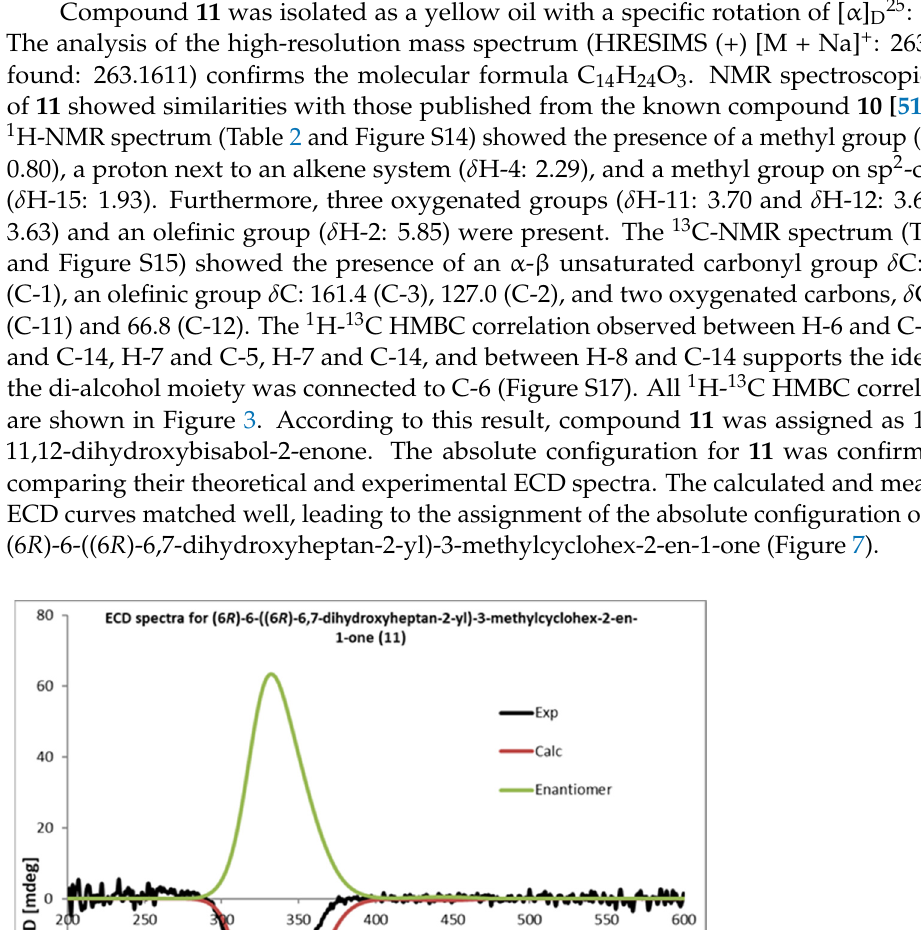
Figure 7. Experimental and calculated ECD spectra of compound 11 permit to assign the configuration as (6 R )-6-((6 R Table 2. NMR data of novel compounds isolated from Baccharis species. 7A